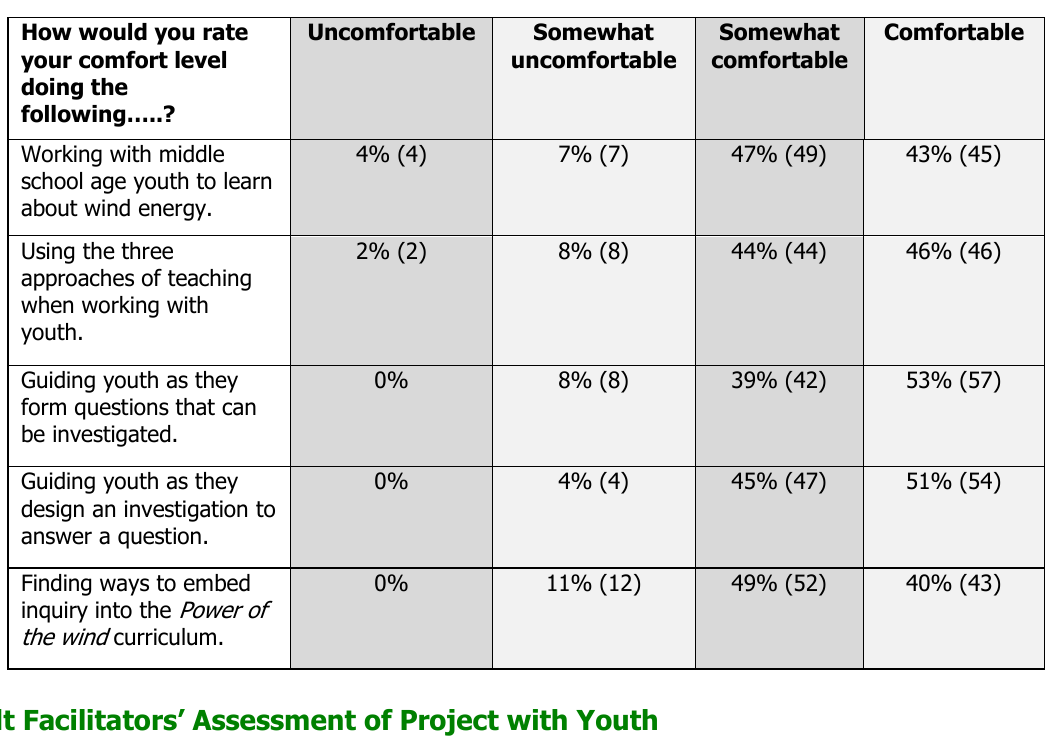
Adult Facilitators’ Post-Training Self-Assessments